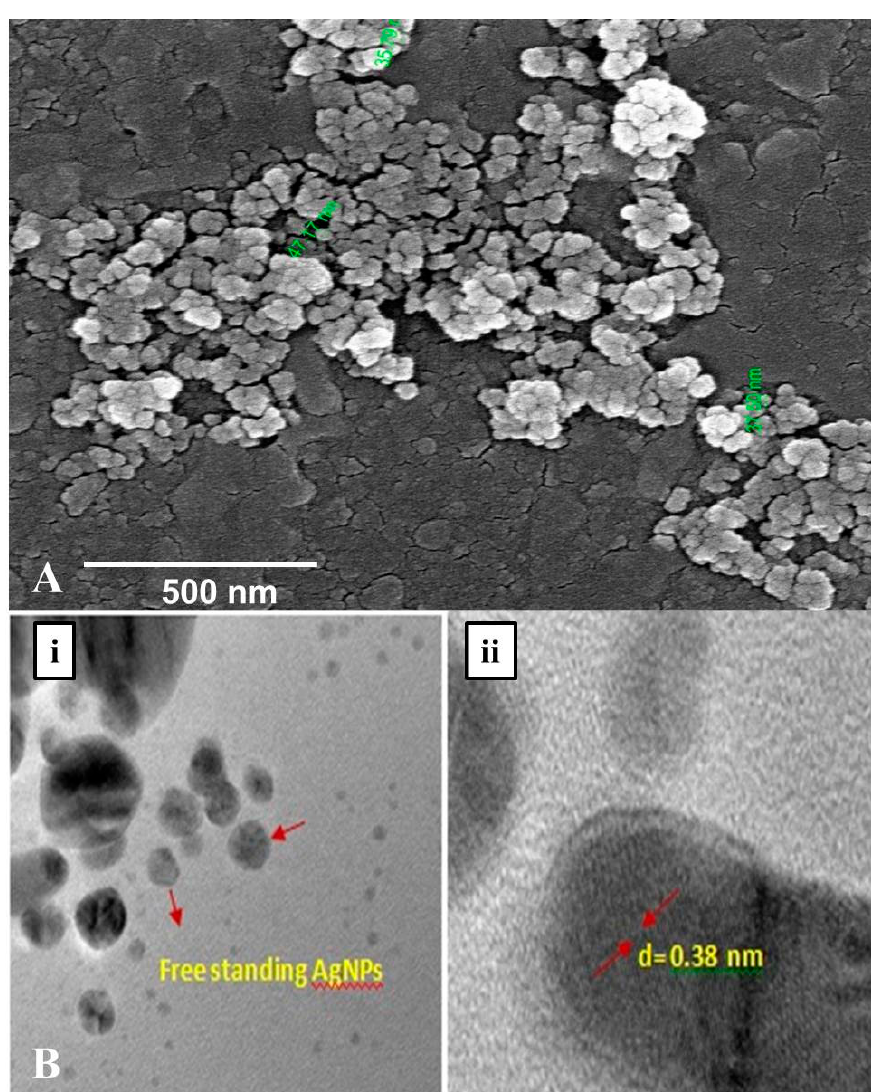
Figure 6. Morphological characterization through FE–SEM ( A ) and HR–TEM ( B ) microscopy